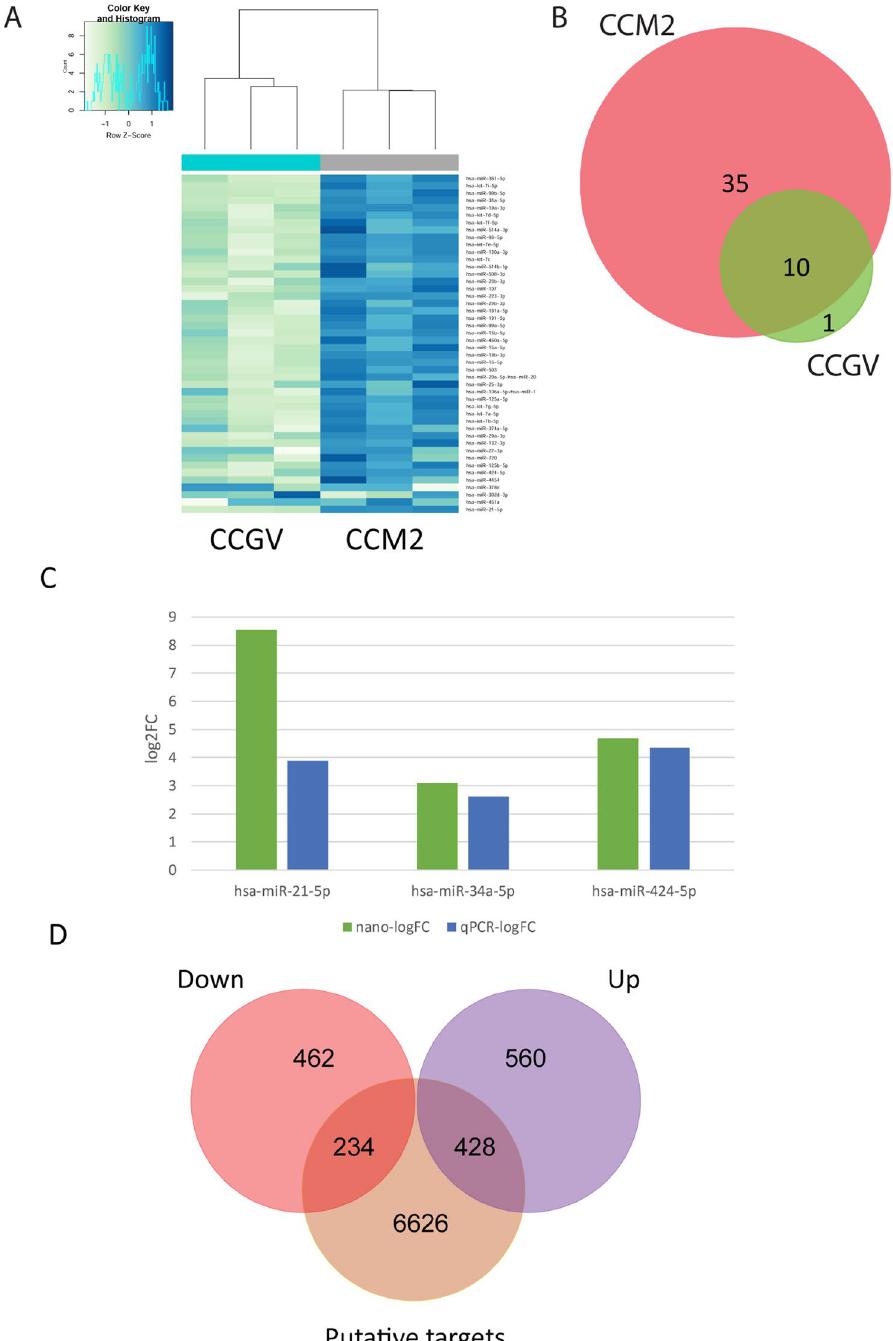
Figure 1. ( A ) Hierarchical clustering of CCGV (n = 3) and CCM2 (n = 3) samples based on miRNA expression levels. Each column represents a sample and each row represents a transcript. Expression level of each miRNA in a single sample is depicted according to the color scale. ( B ) Venn diagram of selective and co-expressed miRs in CCGV and CCM2 samples. A total of 45 miRs were expressed in CCM2 (pink) and 11 miRs were expressed in CCGV (green). Most notably, 35 miRs were exclusively expressed in the IVF group and 10 miRs were shared by both samples. ( C ) Total mRNA was purified from CCs denuded from GV COC aspirated during IVM procedures (CCGV) and CCs denuded from M2 COC (CCM2) aspirated during IVF procedures. The miRNAs were subjected to qPCR in duplicate with the examined genes and RNU6B primers. Gene expression was calculated relative to the RNU6B level in the same sample and expression levels were compared using Student’s t-test. The difference reached a level of significance (P < 0.05) for all tested genes. NanoString (green) and qPCR (blue) results are presented as log2- fold change between CCM2 and CCGV samples. ( D ) Venn diagram showing the relationship between the putative miRNA targets (brown) and experimentally differentially expressed mRNAs (from Yerushaslmi et al . 3 , upregulated mRNA (purple), downregulated mRNA (red)). Of all the putative miRNA targets, 234 were negatively